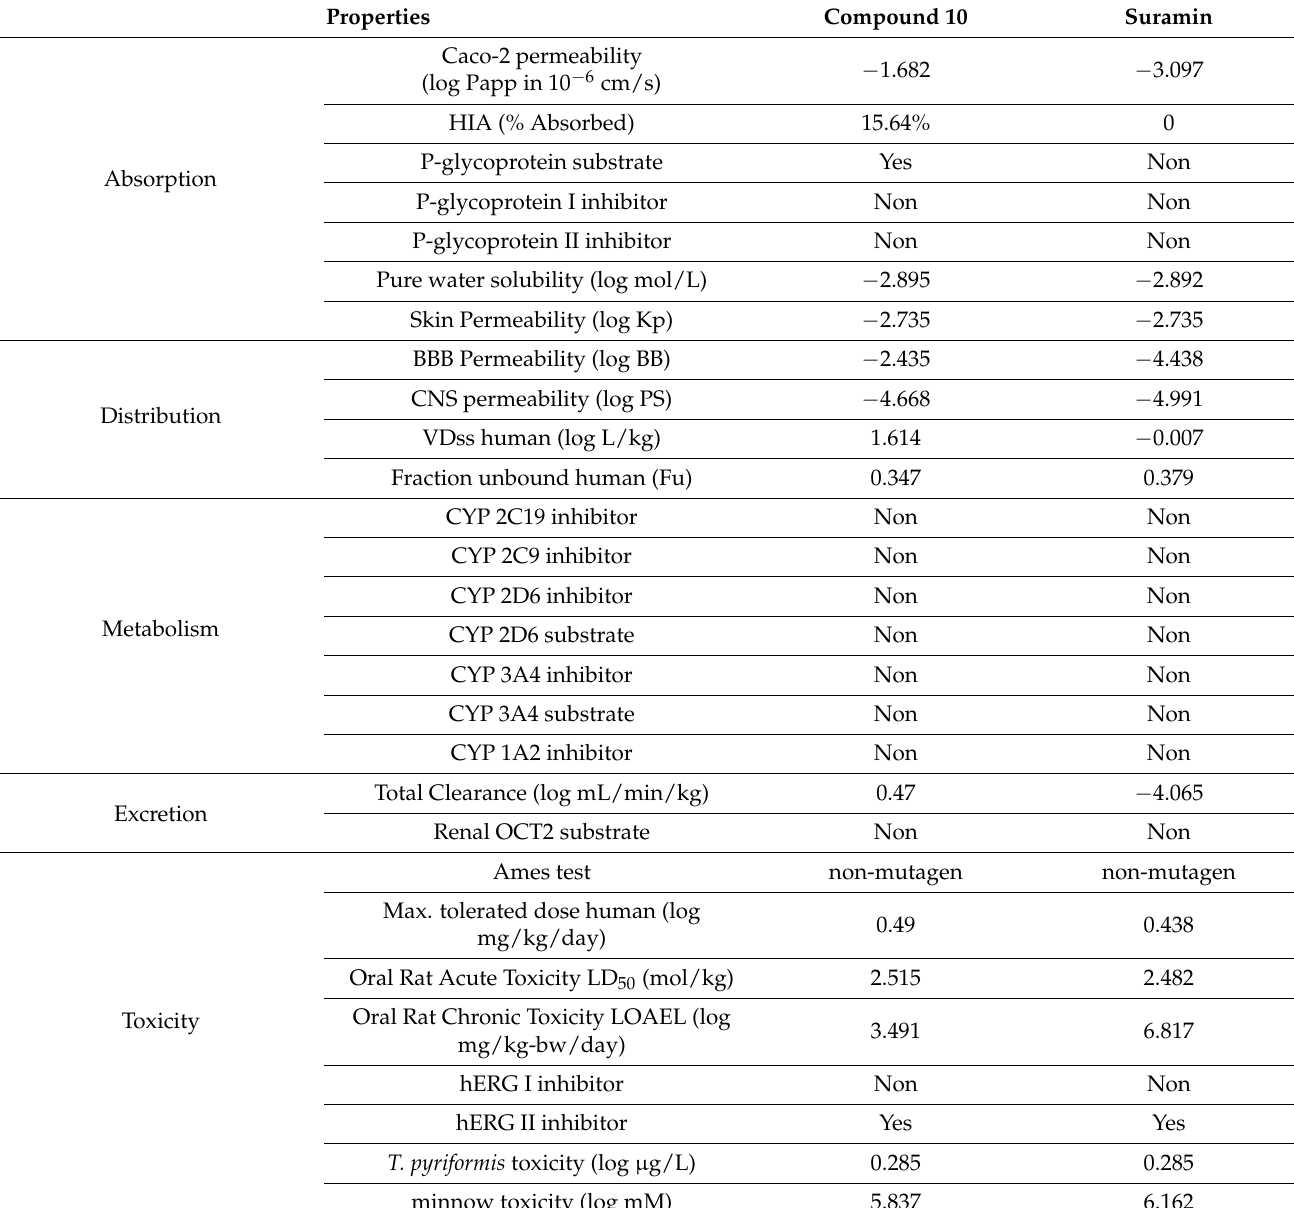
Table 2. ADMET properties of compound 10 and